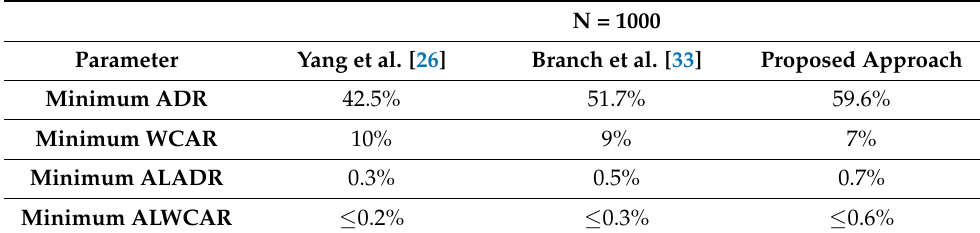
Table 5. Comparative detection ratio analysis at subgroup level. N = 1000 Parameter Yang et al. [26] Branch et al. [33] Proposed Approach Minimum ADR 42.5% 51.7% 59.6% Minimum WCAR 10% 9% 7% Minimum ALADR 0.3% 0.5% 0.7% Minimum ALWCAR ≤